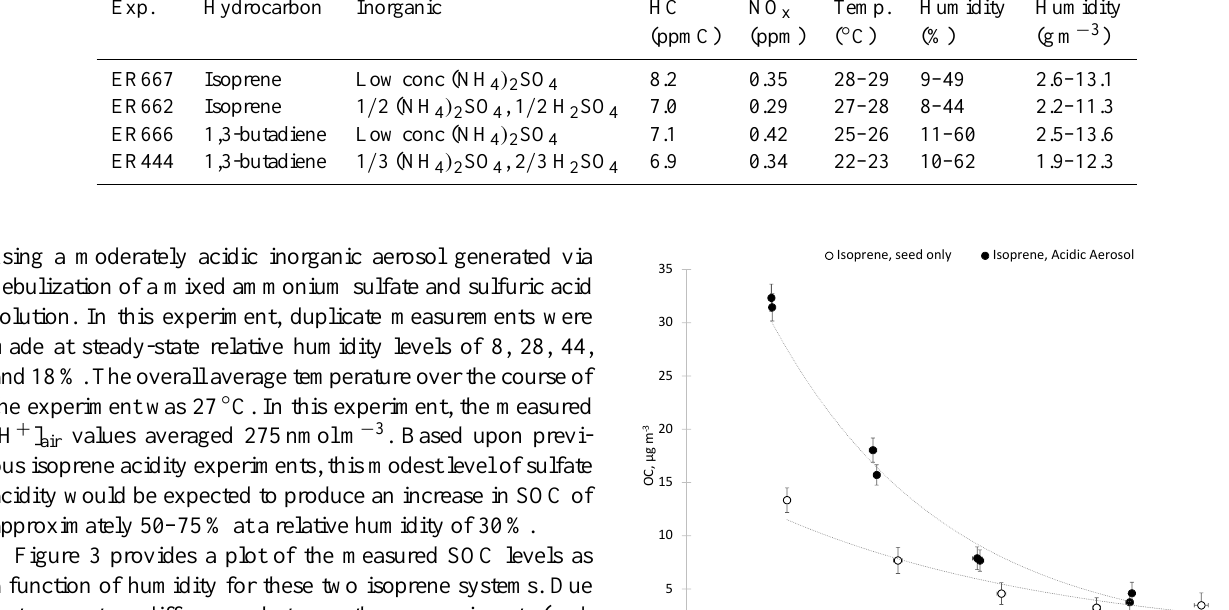
Table 4. Reaction conditions for humidity variation experiments. Exp. NO x Temp.